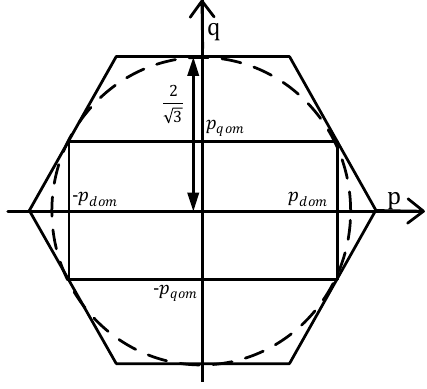
Figure 3. Modified control vector area.